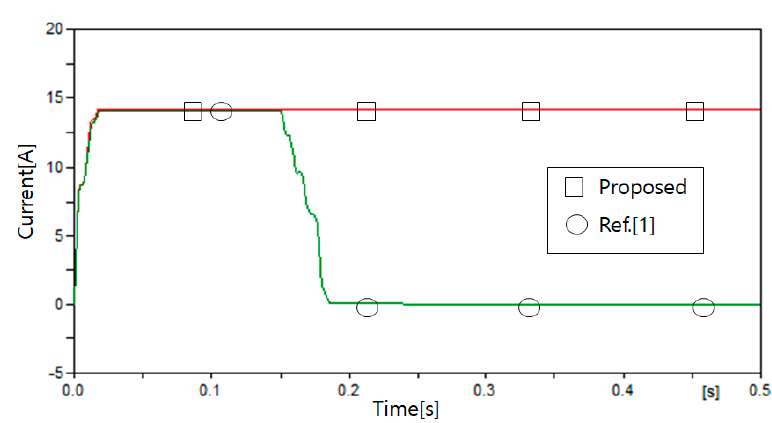
Figure 18. Current measured at Load 6 in Case 4.